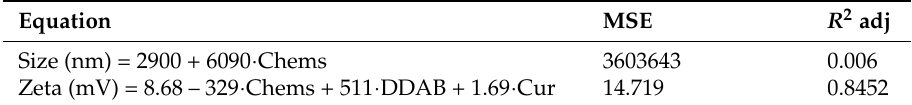
Table 5. Regression equations and fitting parameters for the dependent variables evaluated. MSE: mean square error.